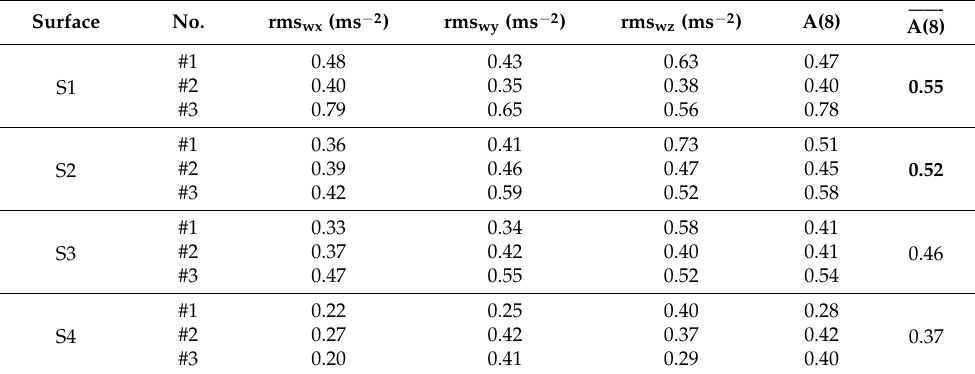
Table 5. Summary of data obtained from driver 2 according to ISO 2631-1:1997, method A(8).